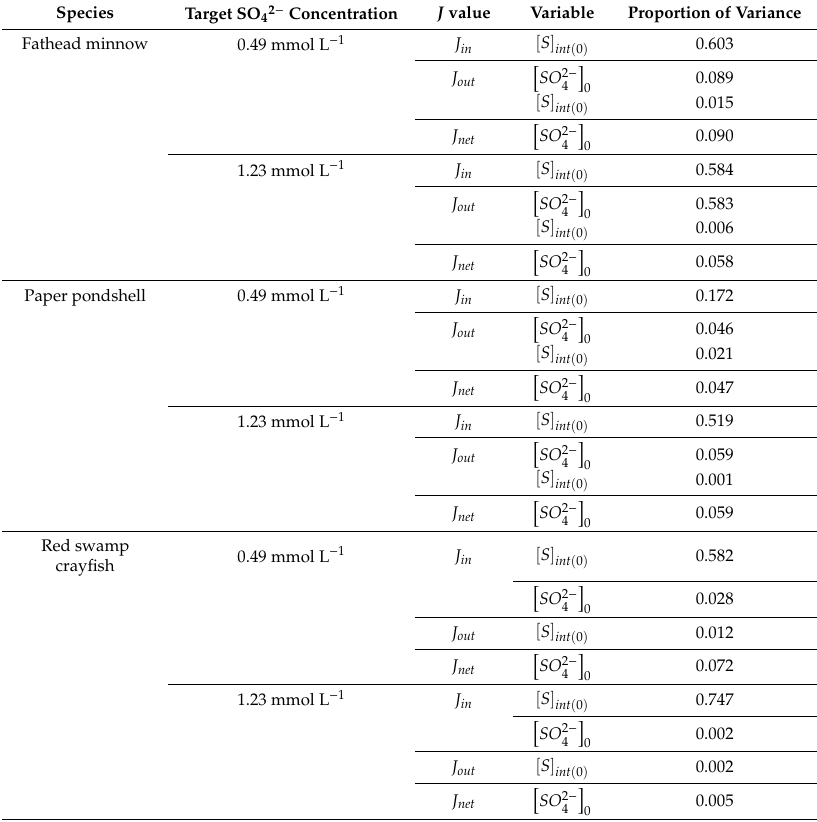
Table 3. Proportion of variance in the J value means contributed by the variances of the mean values for component variables. The proportions of variance for other component variables were < 0.001, or means were not used in the calculations. [S] int (0) is the mean calculated initial S concentration ( µ mol g − 1 ) of each animal, and [SO 42 − ] 0 is the measured concentrations of SO 42 − in the water ( µ mol L − 1 ) at the beginning of the exposure. J in , J out , and J net are the influx rates, e ffl ux rates, and net flux of SO 42 − ( µ mol g − 1 day − 1 ), respectively, for each